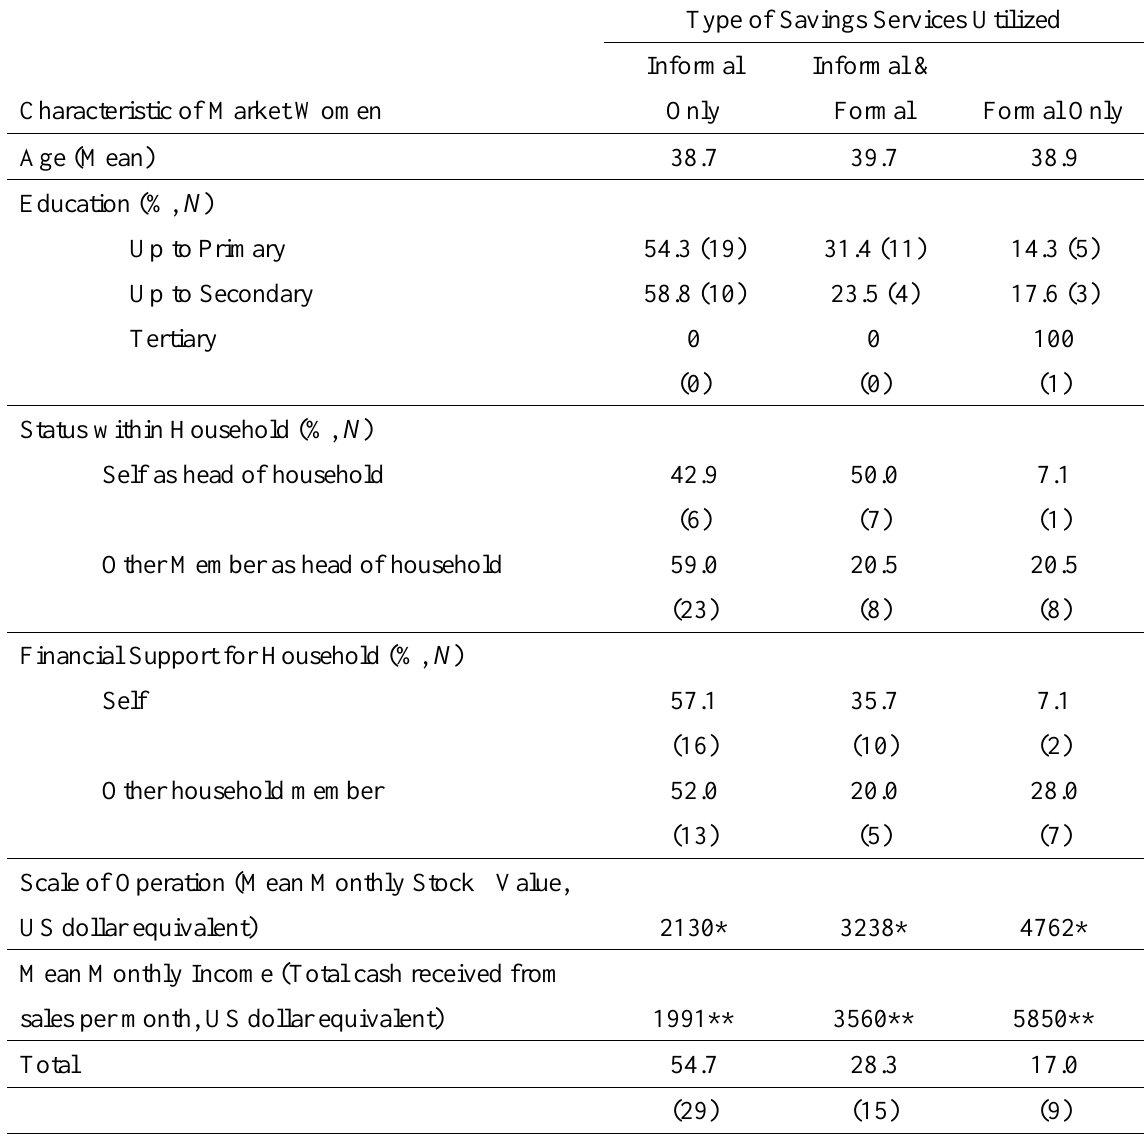
Table 4. Utilization of Savings Service by Profile